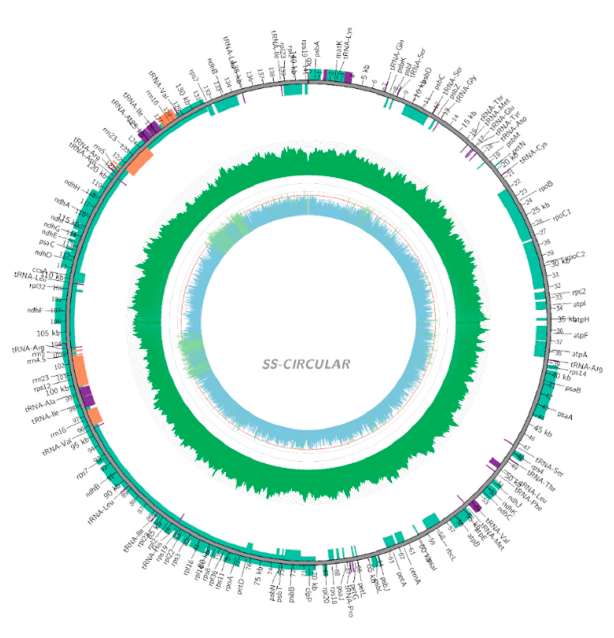
Figure 1. Coverage map for assembly chloroplast sequence genomes of Saccharum o ffi cinarum ( A ) and S. spontaneum ( B ). Outermost circle: genome sequence. Green box: the coding genes; Purple box: tRNA; Orange box: rRNA; Green ring: the coverage depth, of which reverse repeat area is generally two times than that of other areas; Inner circle: GC content of the genome, of which green line representing greater than 50%, and blue for smaller than